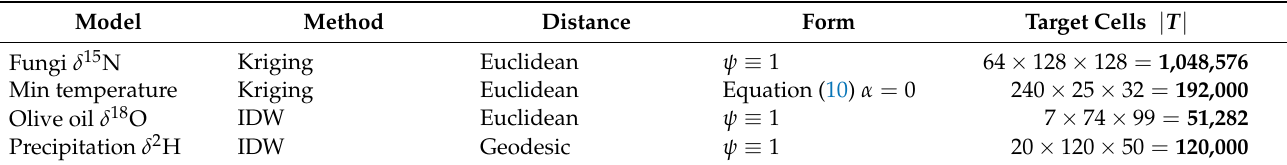
Table 3. Model parameters. The target cells are ordered by time × horizontal ×